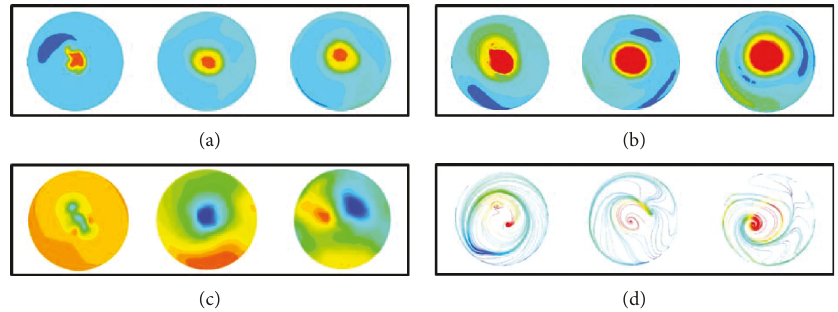
Figure 9: Contour of liquid phase fraction (a), velocity (b), pressure (c) and secondary flow (d). (The three figures in each part represent sections (1), (2), and (3) from left to right.).